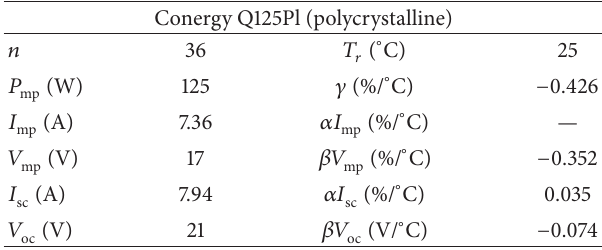
Table 3: Characteristic points of Q125PI solar panel (Conergy), included in the manufacturer’s datasheets at Standard Test Con- ditions (STC): 1000W/m 2 irradiance, 25 ∘ C cell temperature, and AM1.5 g spectrum according to EN 60904-3